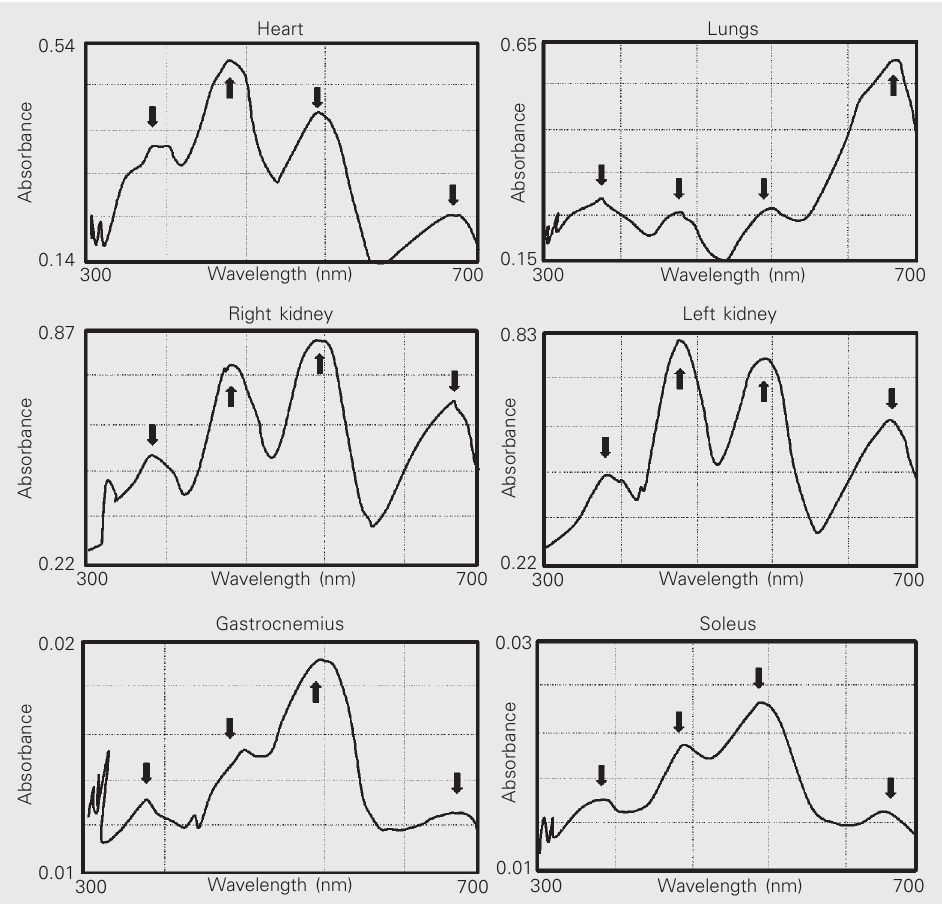
0.01Figure 1. Spectrum of four dif- ferent colors of the dye solution obtained from microspheres in heart, lungs, right and left kid- neys, soleus and gastrocnemius muscles from one rat. Arrows indicate the wavelength of the absorbance of white (370 nm), yellow (448 nm), red (530 nm), and blue (672 nm) colors for the calculation of tissue blood